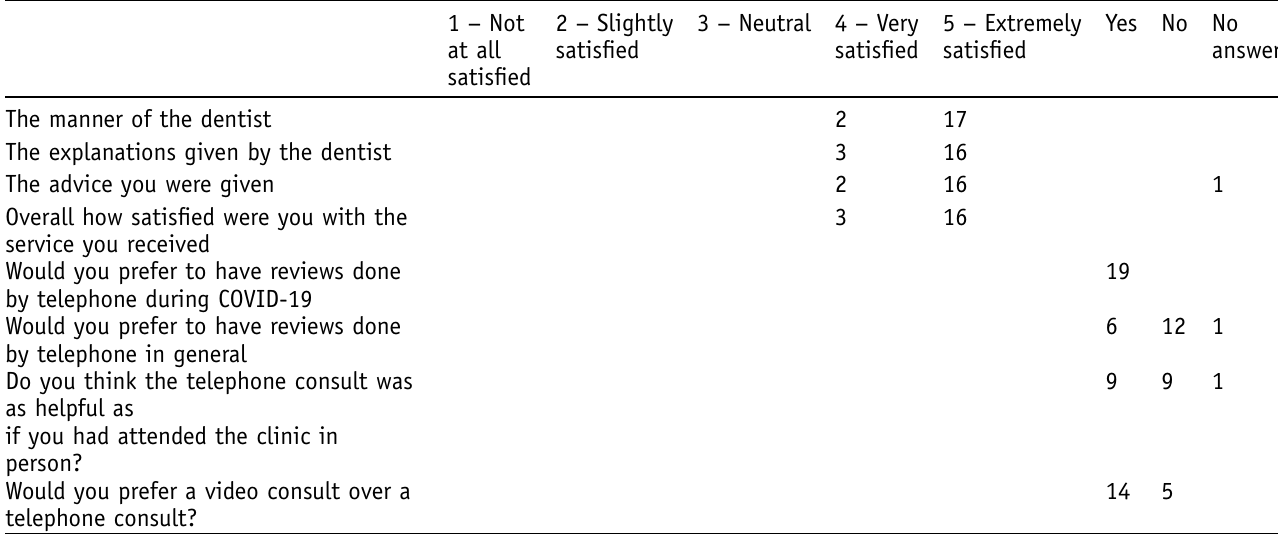
Table I. Oral medicine telephone satisfaction